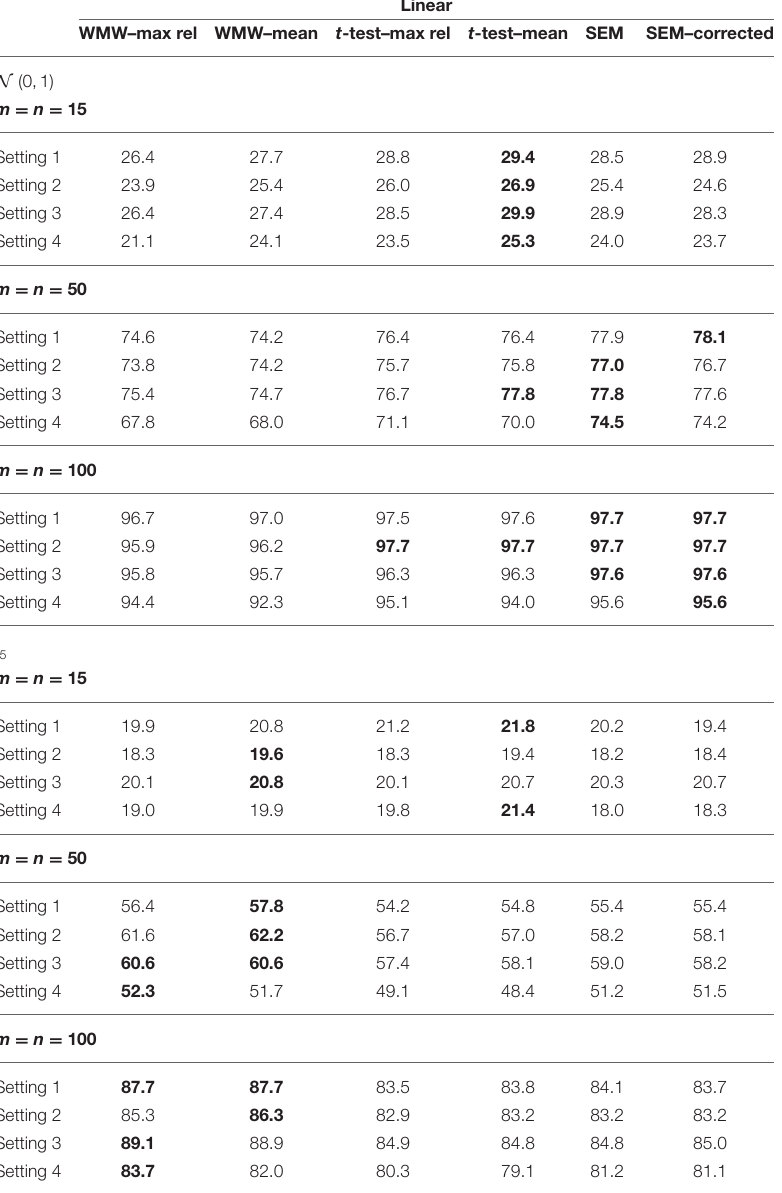
The highest power per setting is indicated in